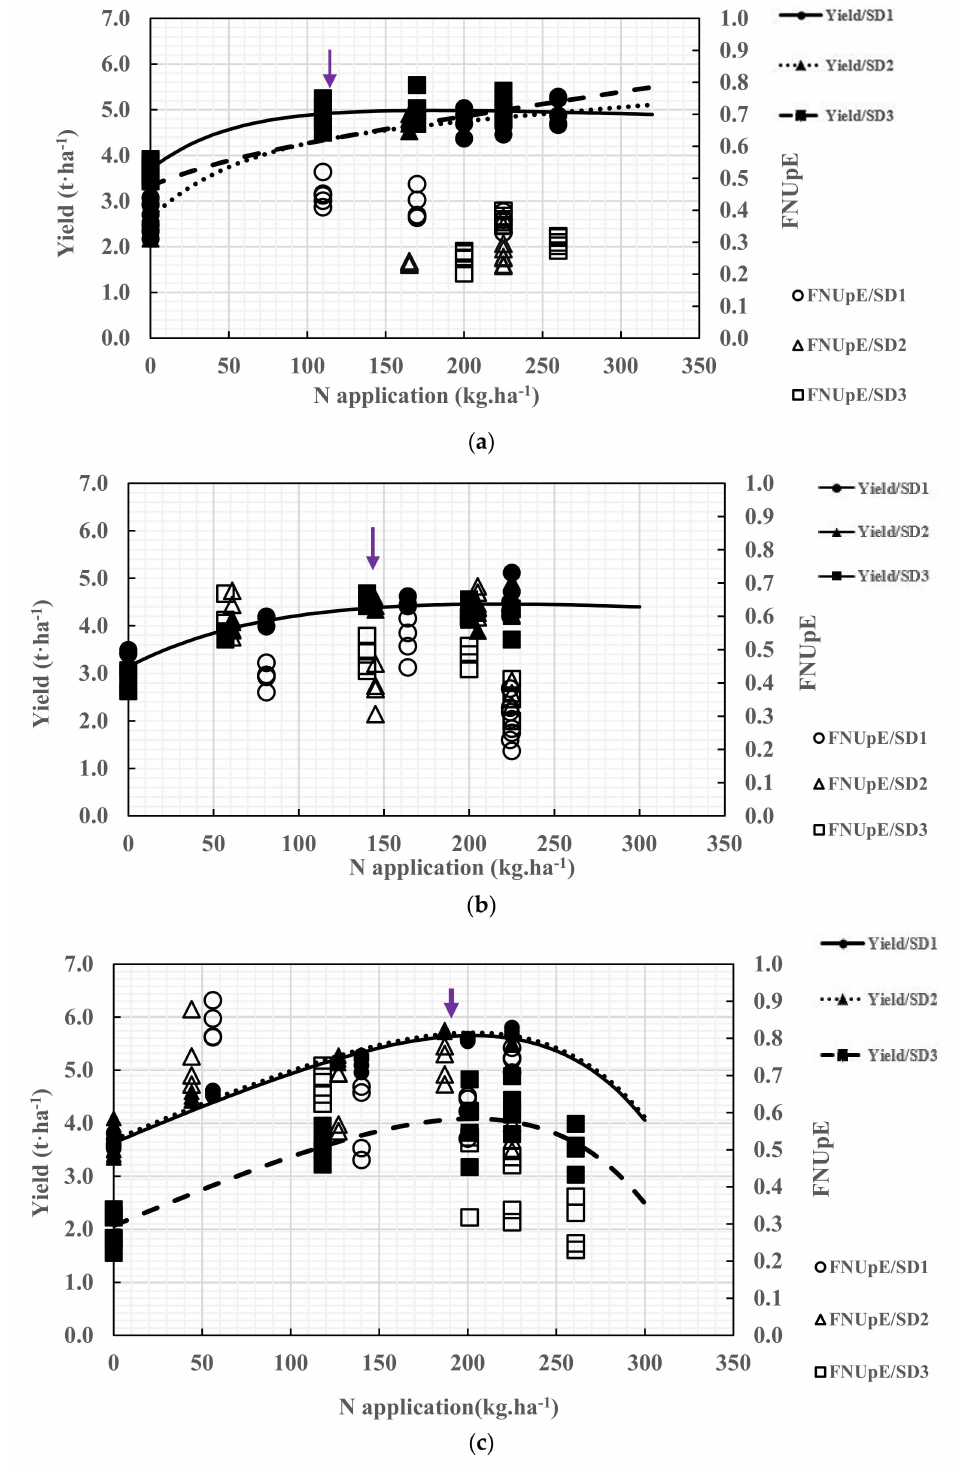
Figure 1. ( a – c ). Fitted linear plus exponential curves from N rates and yield, plus FNUpE data points on secondary y-axis from site-year 1 to 3. ( a ); is related to site-year 1 with the fitted curve only on SD1; ( b ) shows site-year 2 one fitted curve on all SDs; ( c ) is associated with site-year 3, with three parallel curves for each SDs, and FNUpE data points. The arrow shows the calculated